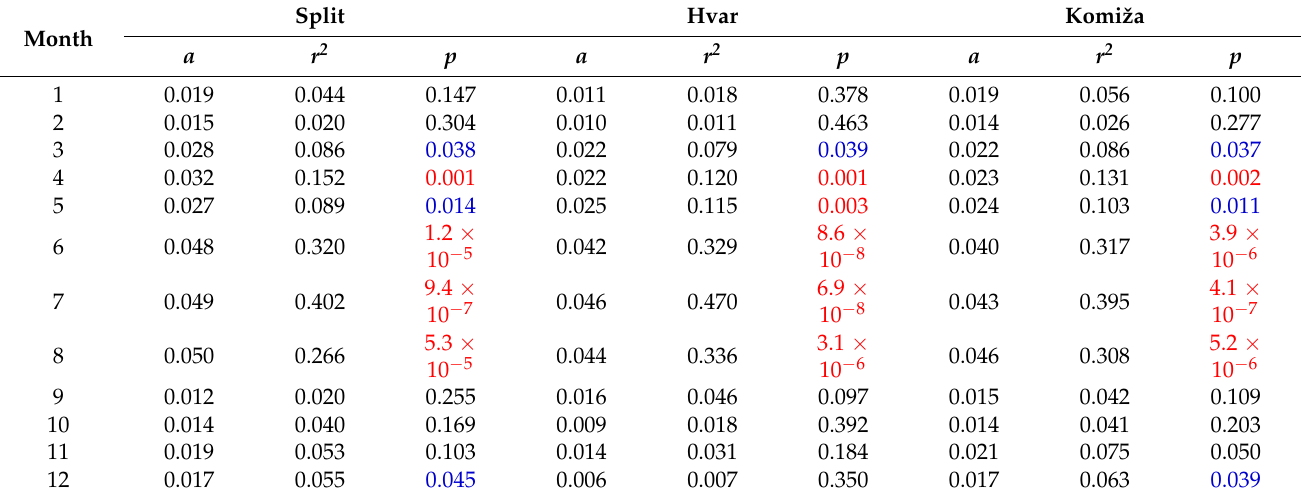
Table 7. The r –squared values of the linear correlation coefficient, r 2 , slope of the linear equation, a, and M–K probability values, p , calculated from the time series of mean monthly air temperature. M–K p values 0.01 < p < 0.05 are highlighted in blue, and p < 0.01 in